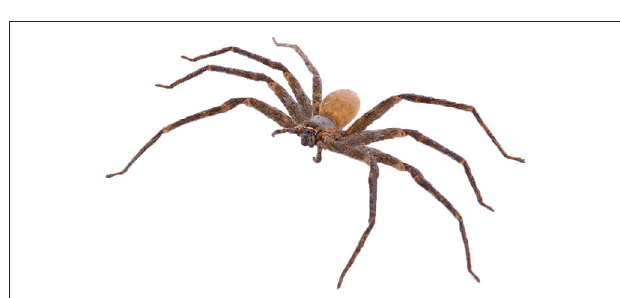
FIGURE 4 | Experimentally manipulated legs of spider.